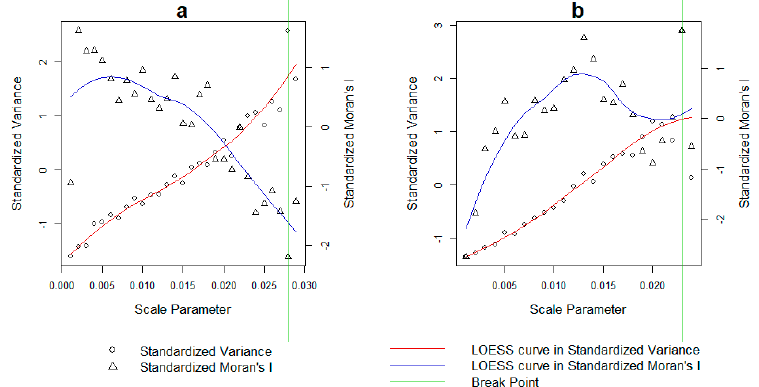
Figure 6. LOESS curve results for the two ROIs. The breakpoint signifies the point where the absolute residuals are larger than 0.4 standard deviations for both Variance and Moran’s I and their sum greater than 1. In ROI 1 ( a ) the breakpoint was found with a scale parameter of 0.028 while in ROI 2 ( b ) a parameter of 0.023 was identified as suitable.